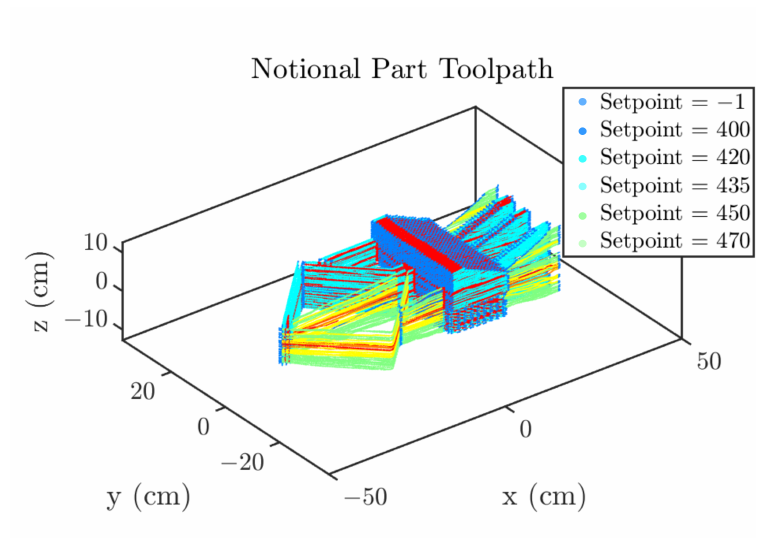
Figure 4. Setpoint locations for NP3 to show the continuity of the printed